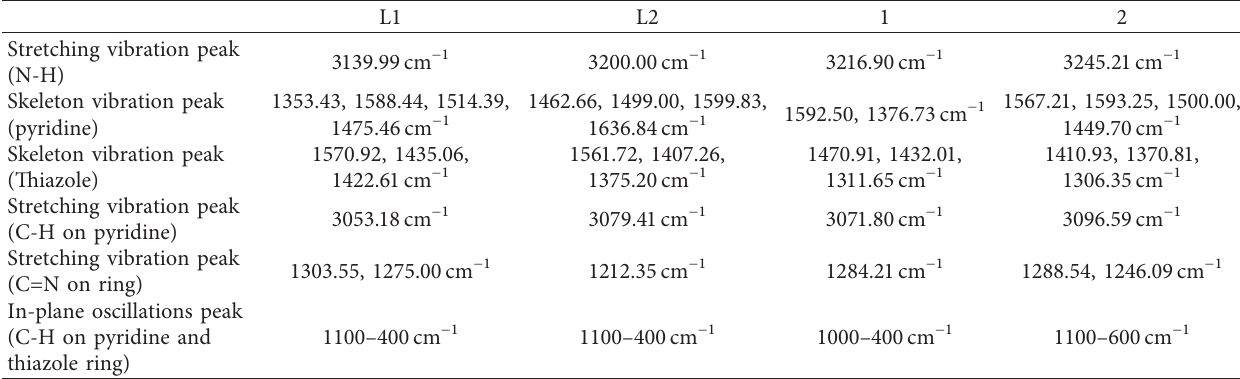
Table 2: Infrared absorption peaks of the main functional groups on ligands L1 and L2 and complexes 1–3 . L1